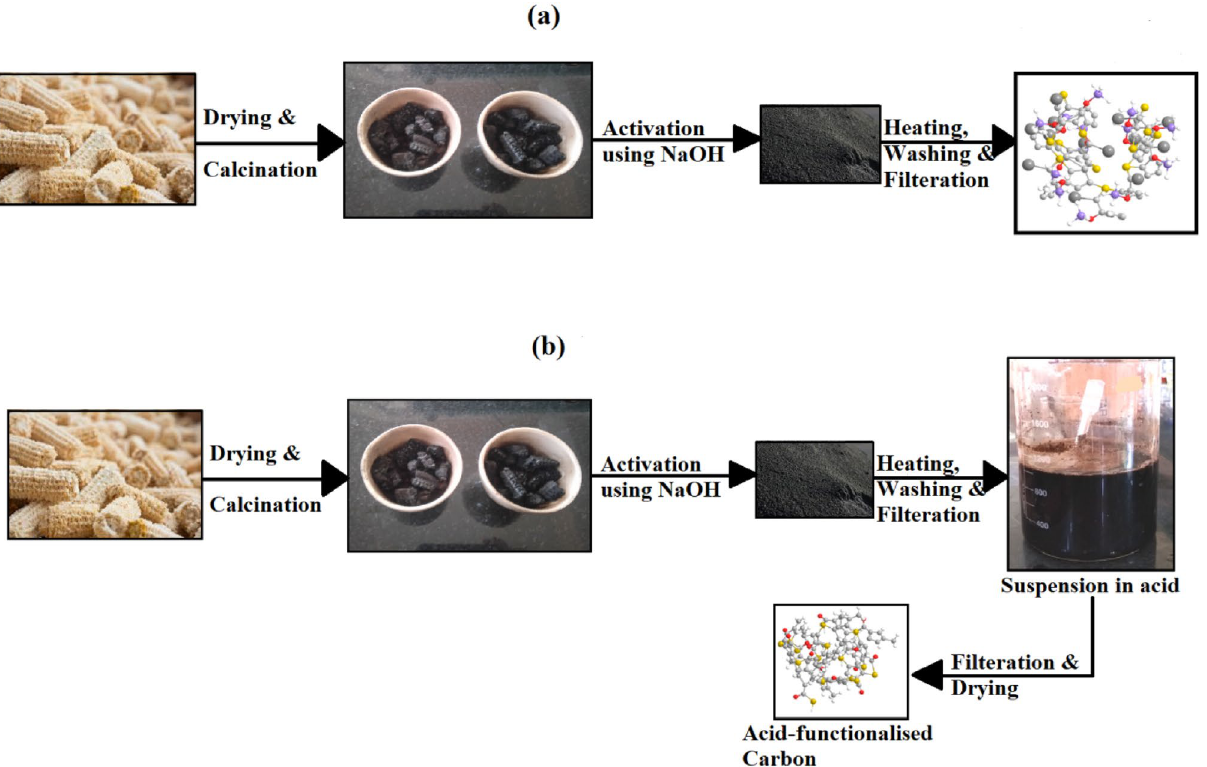
Figure 10. Synthesis scheme of produced ( a ) base-activated carbon, ( b ) acid-activated